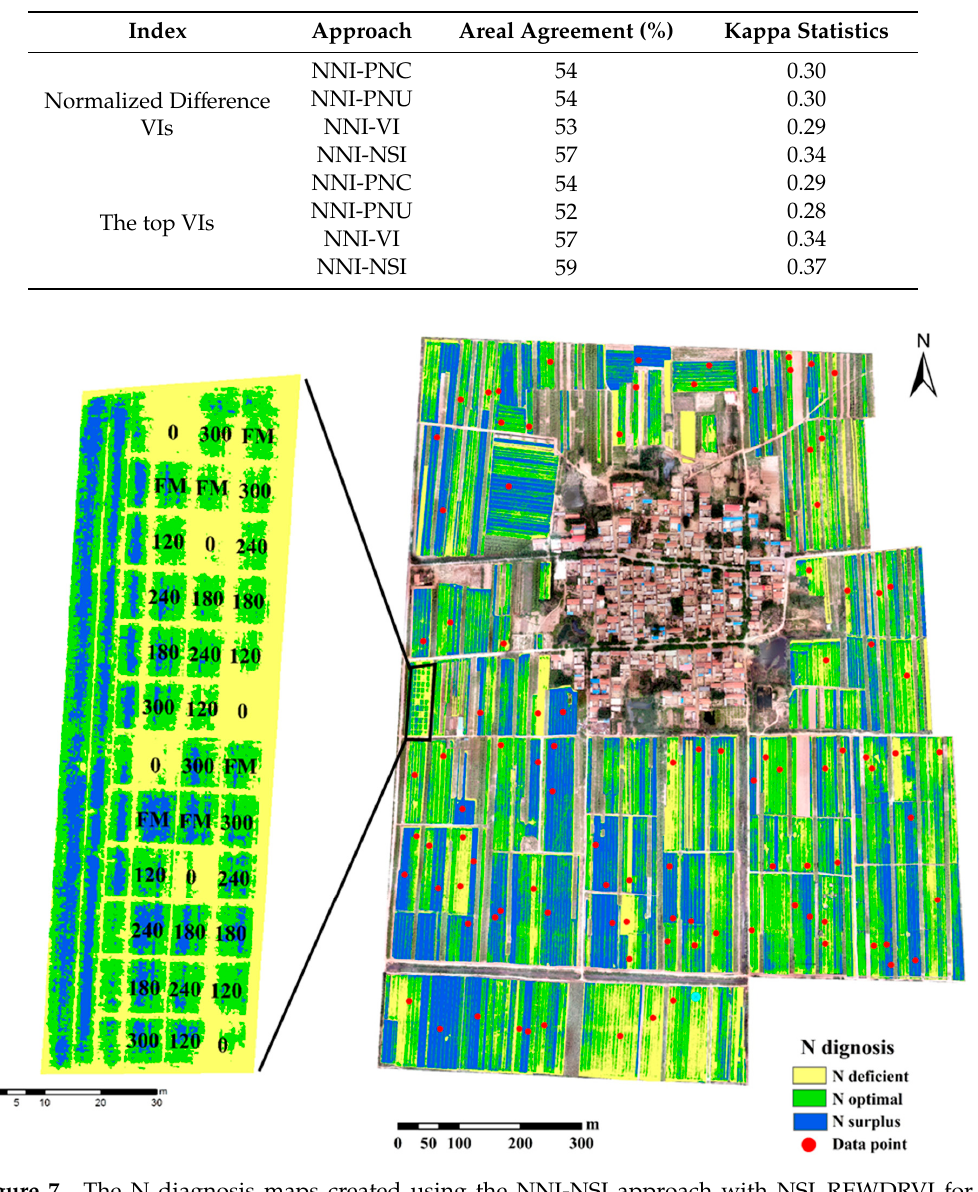
Figure 7. The N diagnosis maps created using the NNI-NSI approach with NSI_REWDRVI for the village’s fields at the pixel level in 2018, Nanxia village, Laoling county, Shandong Province of North China Plain. Red dots ( n = 114) depict the biomass sampling locations in farmer’s fields. The experimental field trial with the 36 sampling plots is shown, where FM indicate farm management, whereas 0, 120, 180, 240, and 300 indicate 0, 120, 180, 240, and 300 kg N ha − 1 .